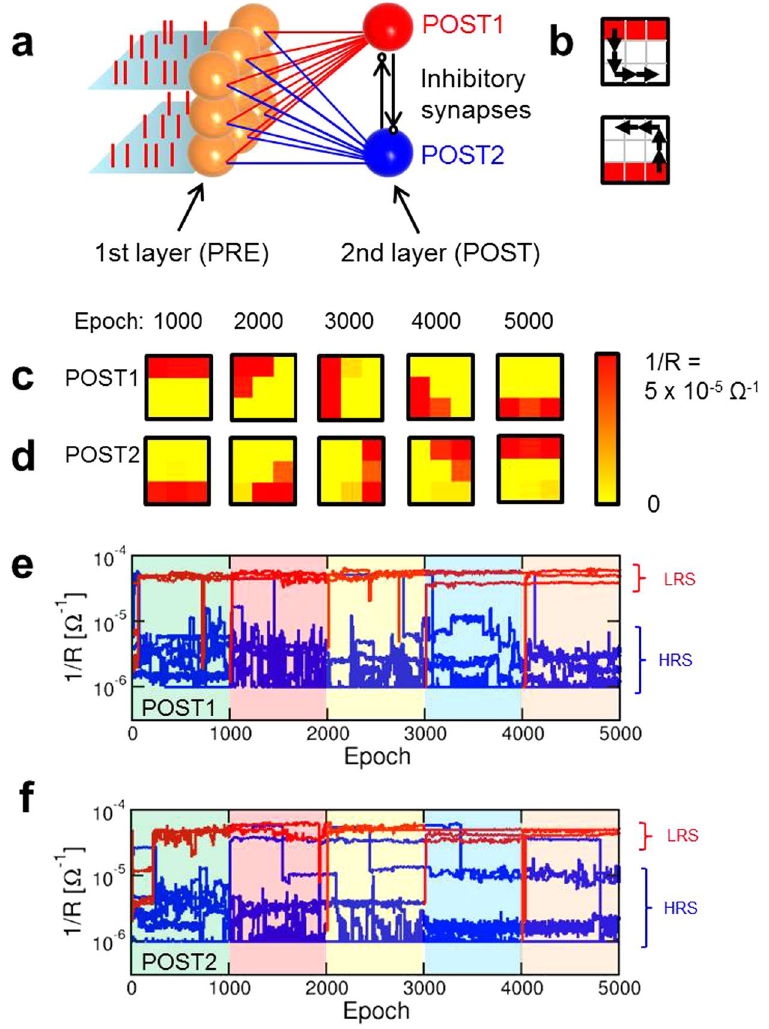
Figure 5. Static and dynamic learning within a 2-POST network. ( a ) Schematic illustration of a perceptron network with a 3 × 3 PRE layer and 2 POSTs, with 18 synapses between the PRE and POST layers. Inhibitory synapses connect the 2 POSTs to reduce the internal potential of one POST when the other POST fires. ( b ) Patterns submitted during the first phase (top and bottom bars for static learning) and sequence of 4 pattern shifts for the dynamic learning phase. ( c,d ) Synaptic weights for POST1 and POST2 at the end of each sequence of learning indicated in ( b ). ( e,f ) Time evolution of the synaptic weights 1/R for POST1 and POST2 during the 5 phases of the dynamic learning. Pattern weights (red) and background weights (blue) tend to LRS and HRS,